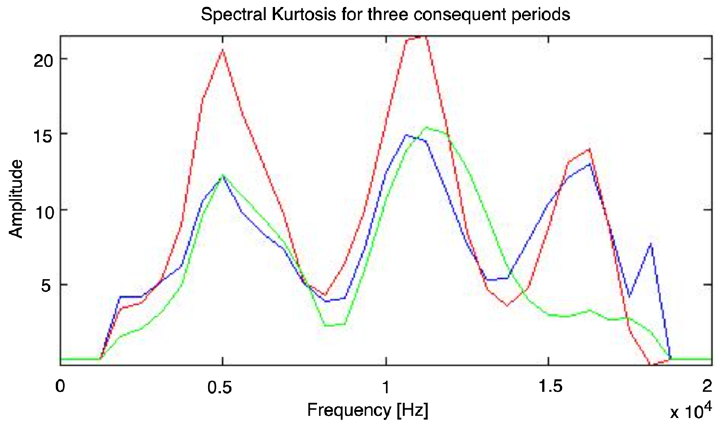
Figure 5. SK for three randomly selected short segments from bearing signal. Three segments are shown with three colors (segment 1 - green, segment 2 - red, segment 3 - blue)